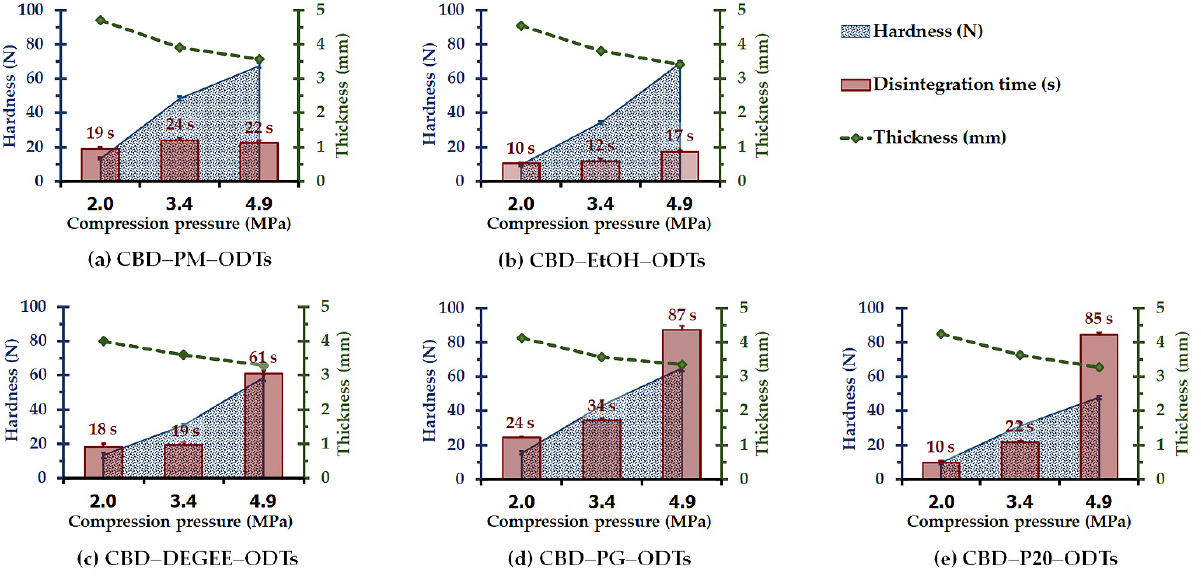
Figure 2. Influence of compression pressure on hardness, disintegration, and thickness of various CBD ODTs containing 8% SSG (mean ± SD, n = 6).